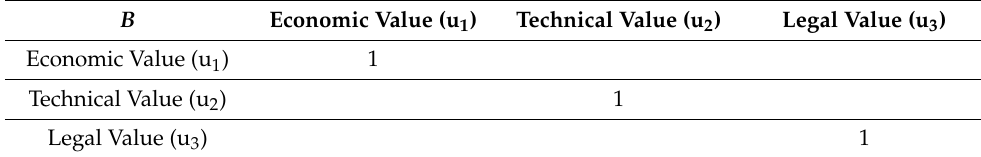
Table A2. Judgment of the importance of economic value indicators. C